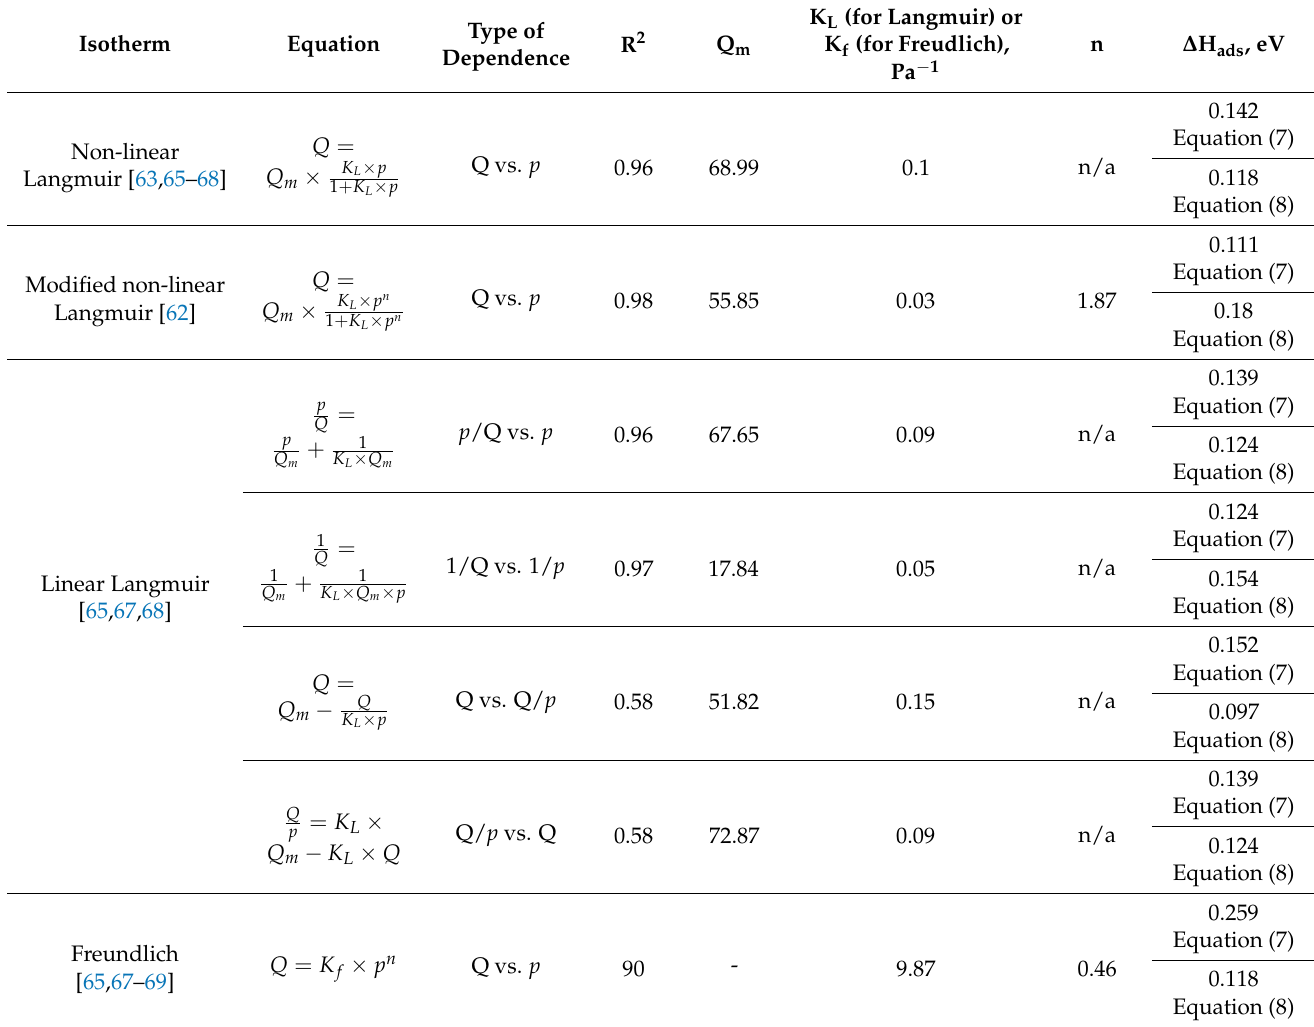
Table 2. Granulated CNF-based NO 2 gas sensor performance compared to the literature data related to different sensor